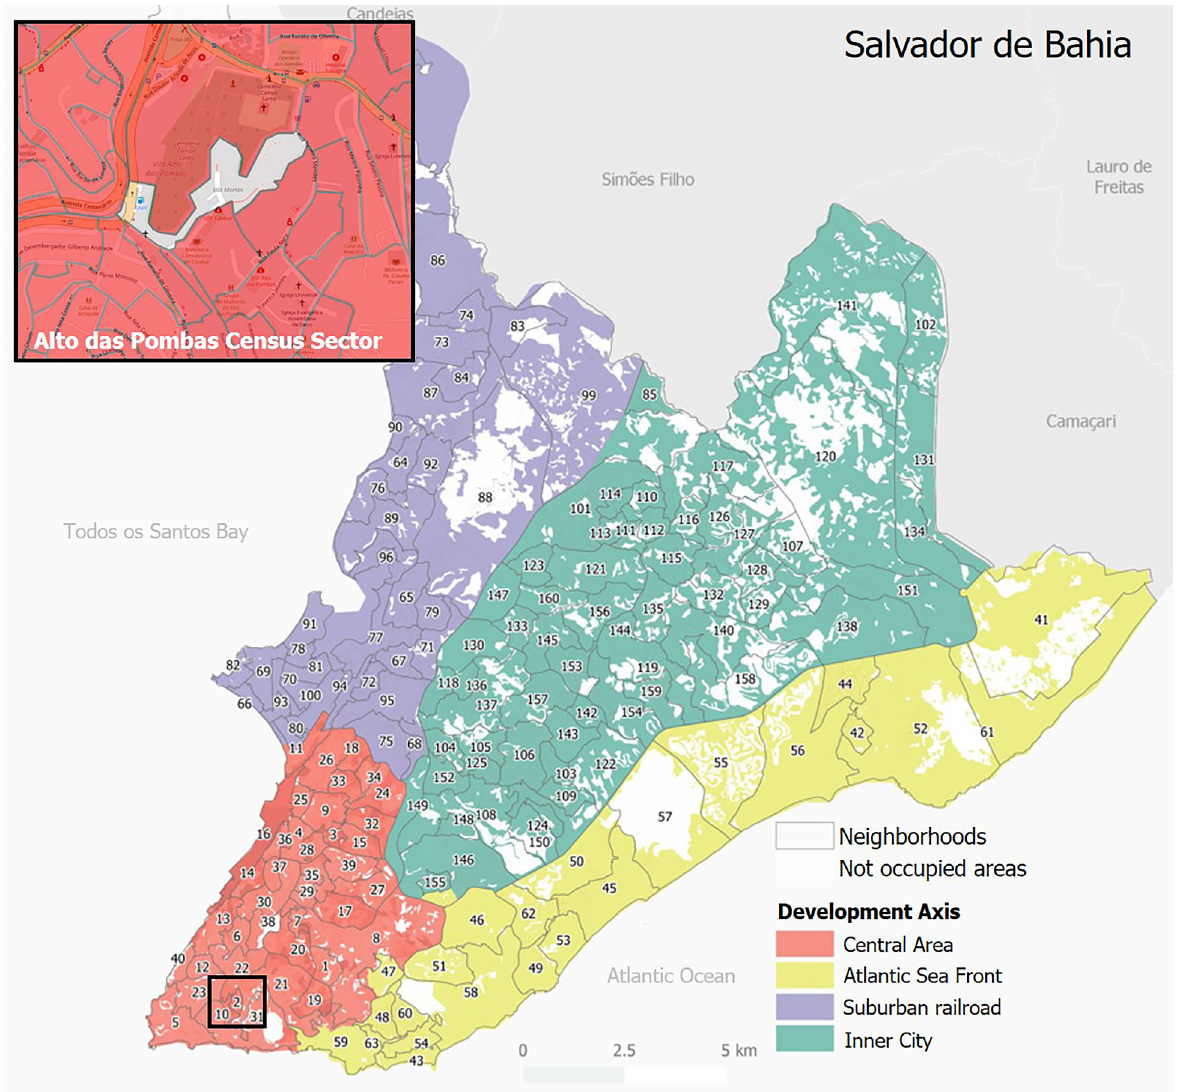
Fig. 2. Salvador de Bahia and the Alto das Pombas Census